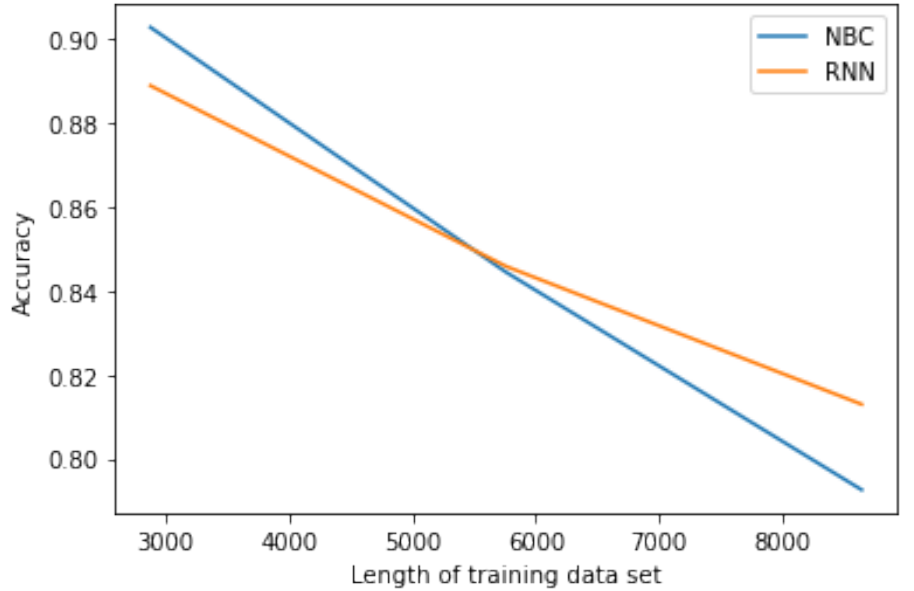
Figure 6. Accuracy scores for both models, plotted against the size of the training data set. Table 2. Accuracy and loss results by data set and the length of all train and sets. Length Data Set